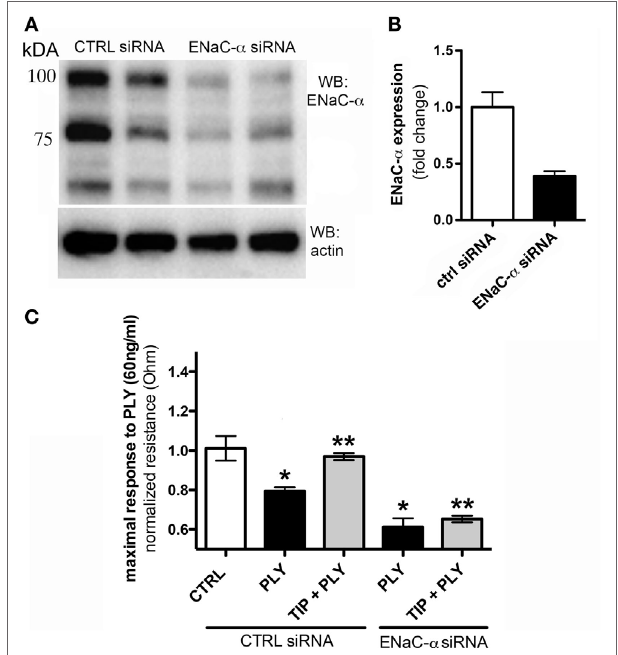
FigUre 2 | (a) Representative western blot of epithelial sodium channel (ENaC)- α expression in human lung microvascular endothelial cells (HL-MVEC), transfected with either scrambled siRNA (control) or ENaC- α siRNA. (B) Efficacy of siRNA-mediated depletion of ENaC- α , relative protein expression in HL-MVEC. (c) Transendothelial resistance (measured in electrical cell-substrate impedance sensing 1600R) in HL-MVEC, transfected with scrambled siRNA or ENaC- α siRNA and treated for 30 min with 60 ng/ml of PLY (corresponding with the maximal drop in resistance), in the presence or absence of TIP peptide (* p < 0.05 versus ctrl, ** p < 0.05 versus PLY).